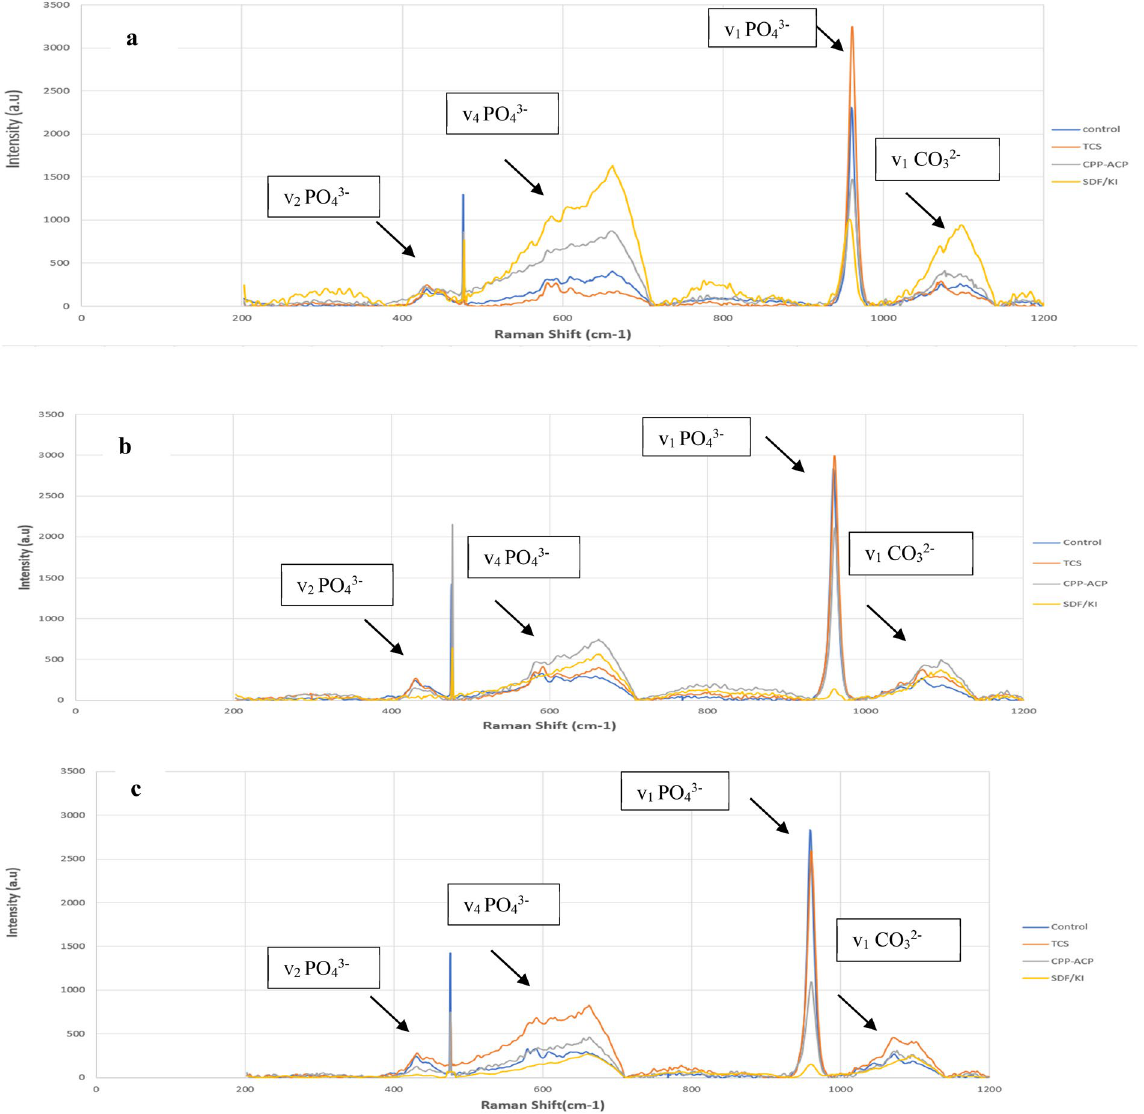
Figure 4. Micro-Raman spectroscopy of remineralized specimens showing the intensity of phosphate (v 1